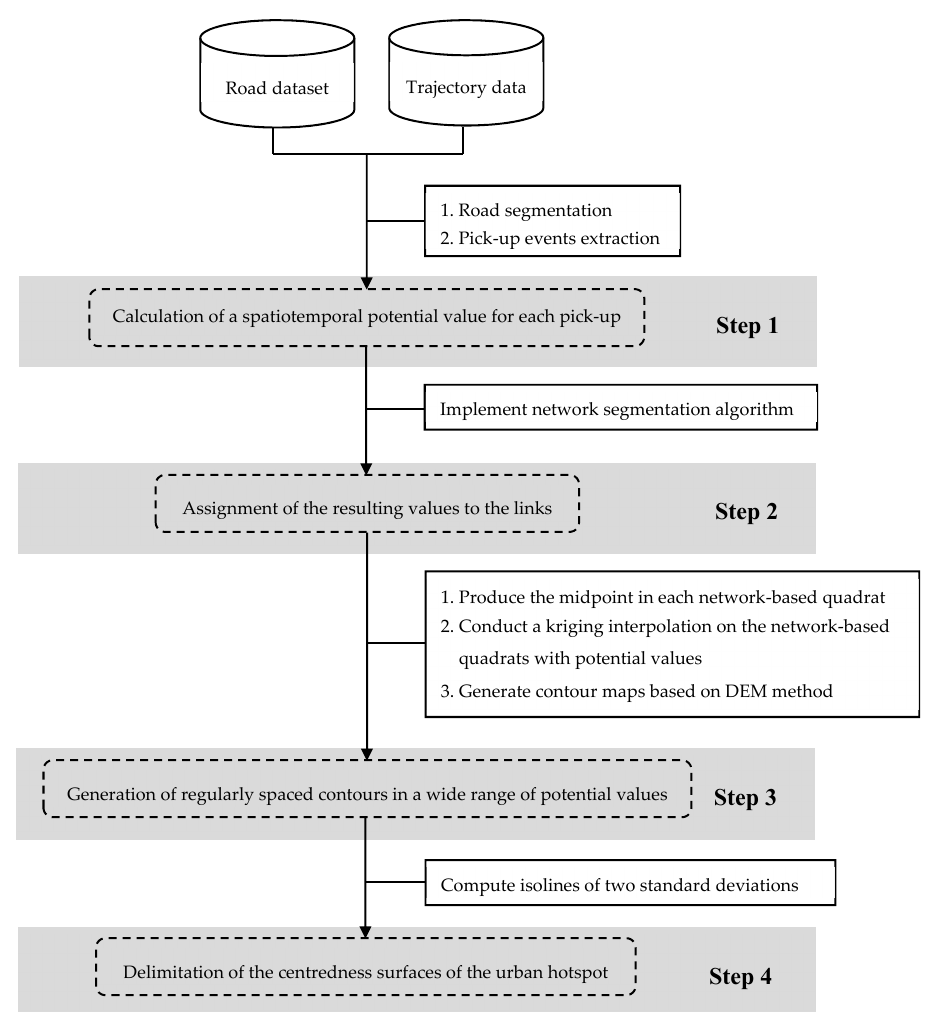
Figure 4. Frame for identifying and delimitating urban hotspot centredness.